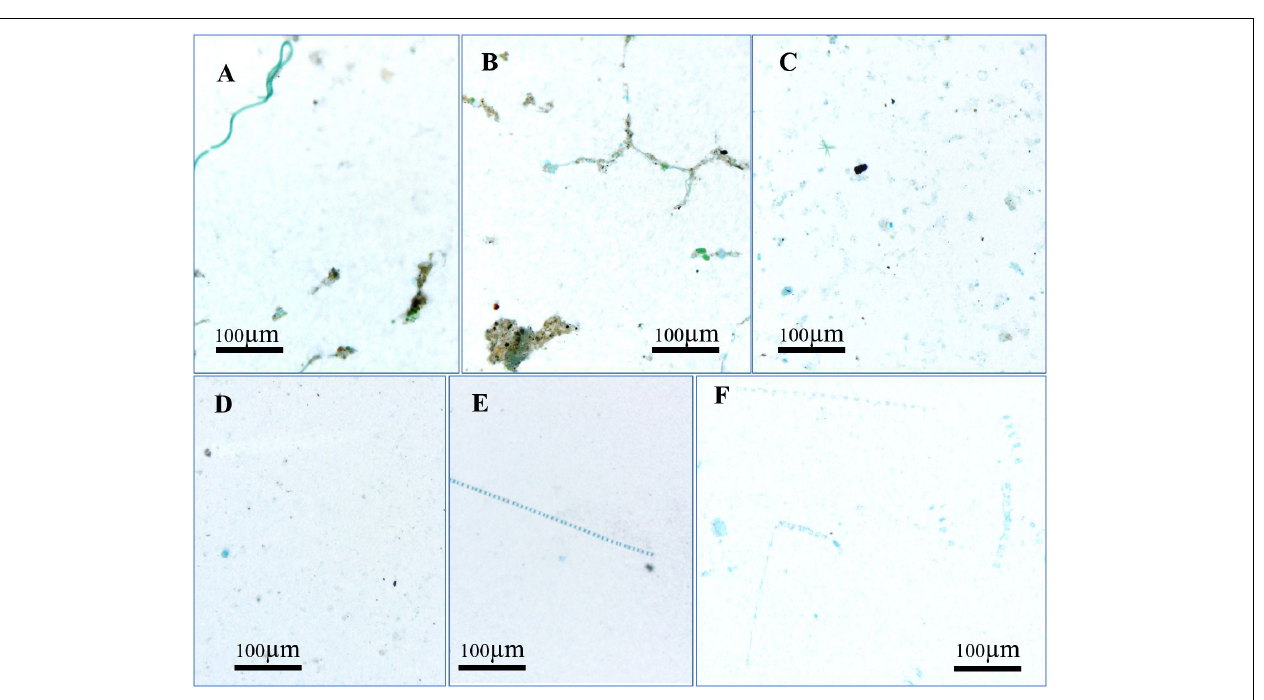
Frontiers in Marine Science |